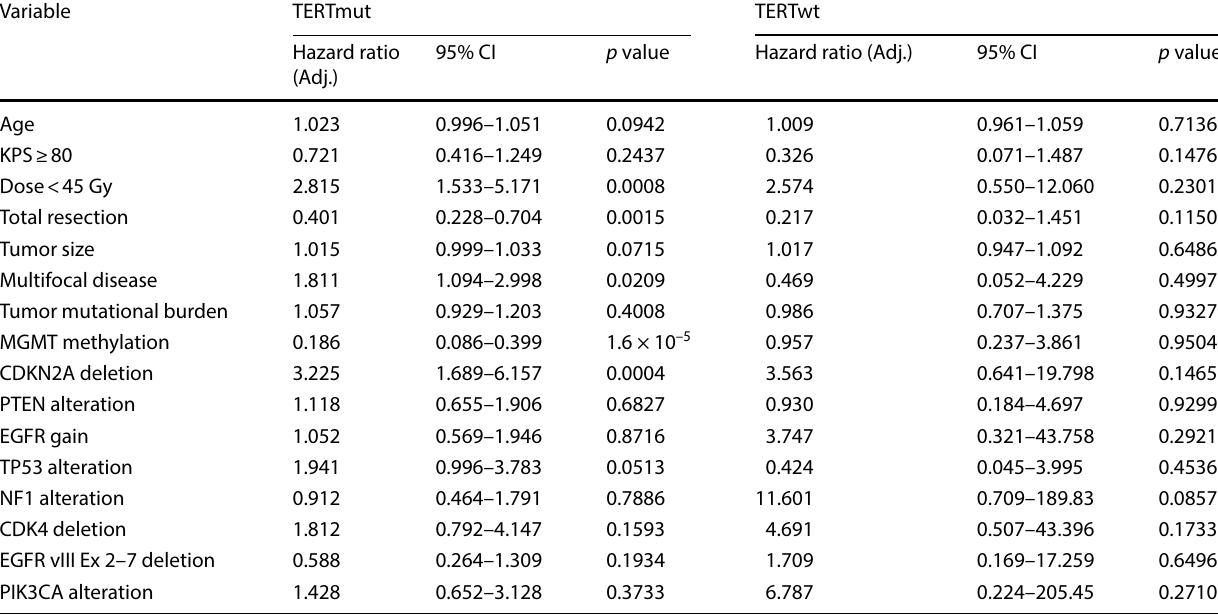
Cox proportional hazards regression was performed on multivariable models on the listed variables. Hazard ratios for age, dose, number fractions, tumor size, and tumor mutational burden were calculated as continuous variables, while the remaining variables were calculated as categorical variables. OS, overall survival; Gy, gray; KPS, Karnofsky performance status; CI,